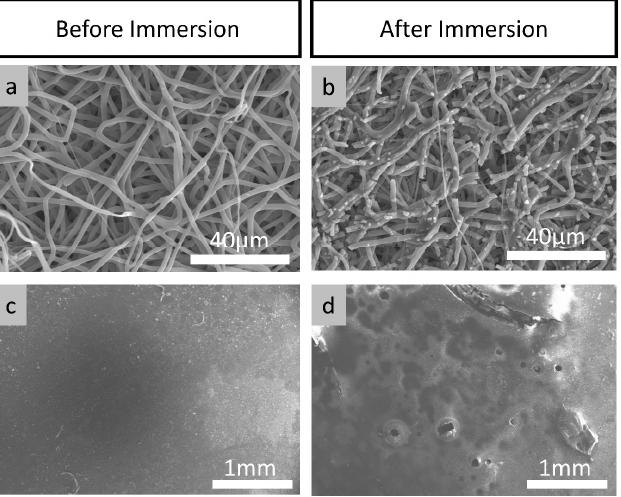
Figure 6. SEM pictures of the coatings before and after immersion in rSBF for nine days: ( a ) electro- spun fiber coating (MgFc) before; ( b ) and after immersion; ( c ) spin coating (MgSc) before; ( d ) and after immersion.